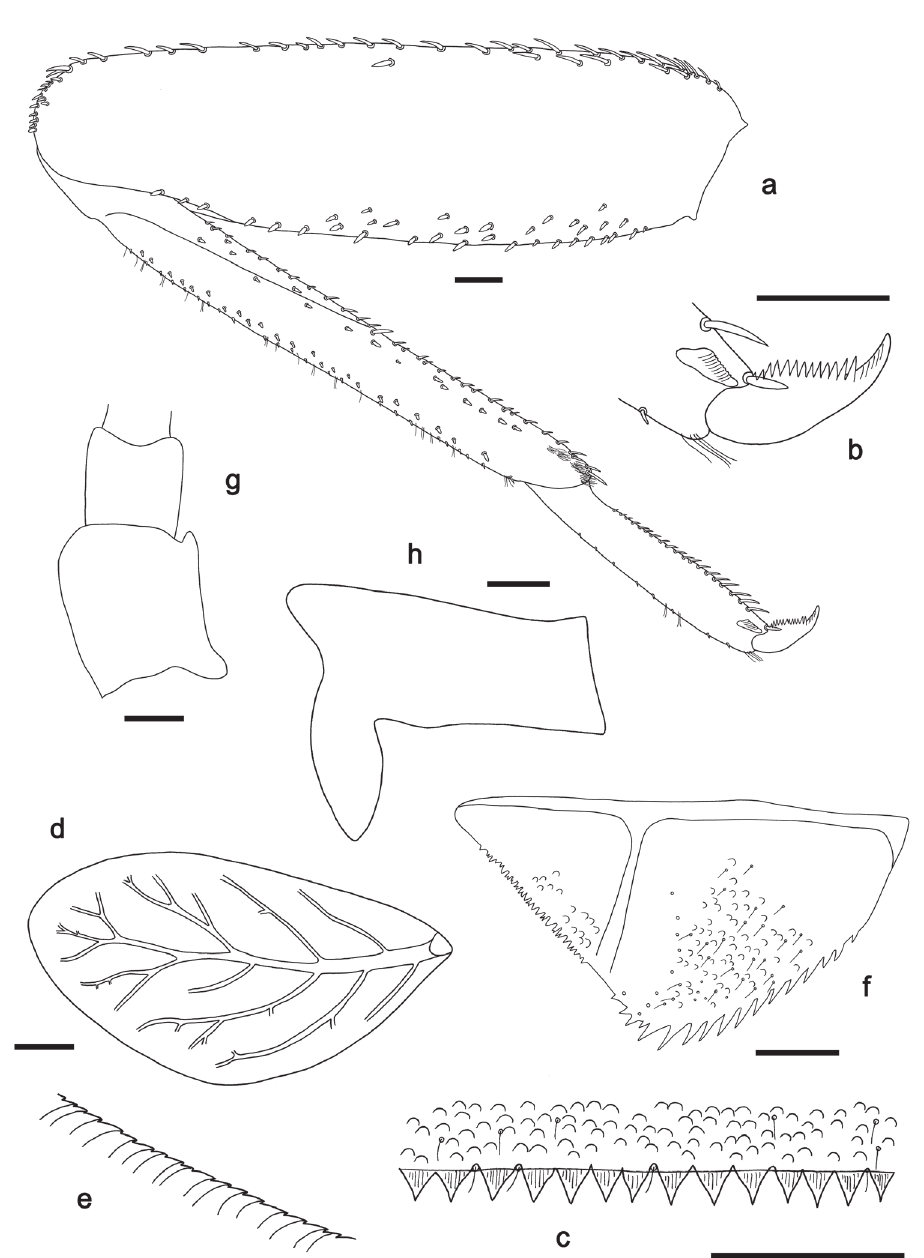
Figure 4. Labiobaetis excavatus sp. nov., nymph morphology a foreleg b fore claw c tergum IV d gill IV e margin of gill IV f paraproct g antennal scape h metanotum. Scale bars: 0.1 mm. than other setae; apex with one long, one medium and one short, robust seta; outer margin with 5–7 spine-like setae increasing in length distally; ventral surface with fine, simple, scattered setae. Paraglossa sub-rectangular, curved inward; apex